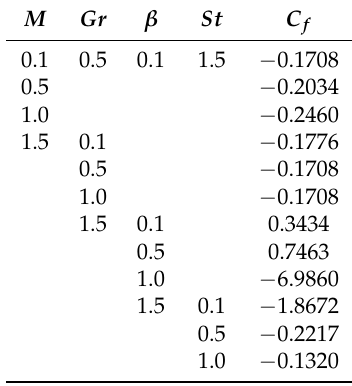
Table 2. Variation in skin-friction coefficent, under dissimilar values of M , Gr , β and St . M Gr